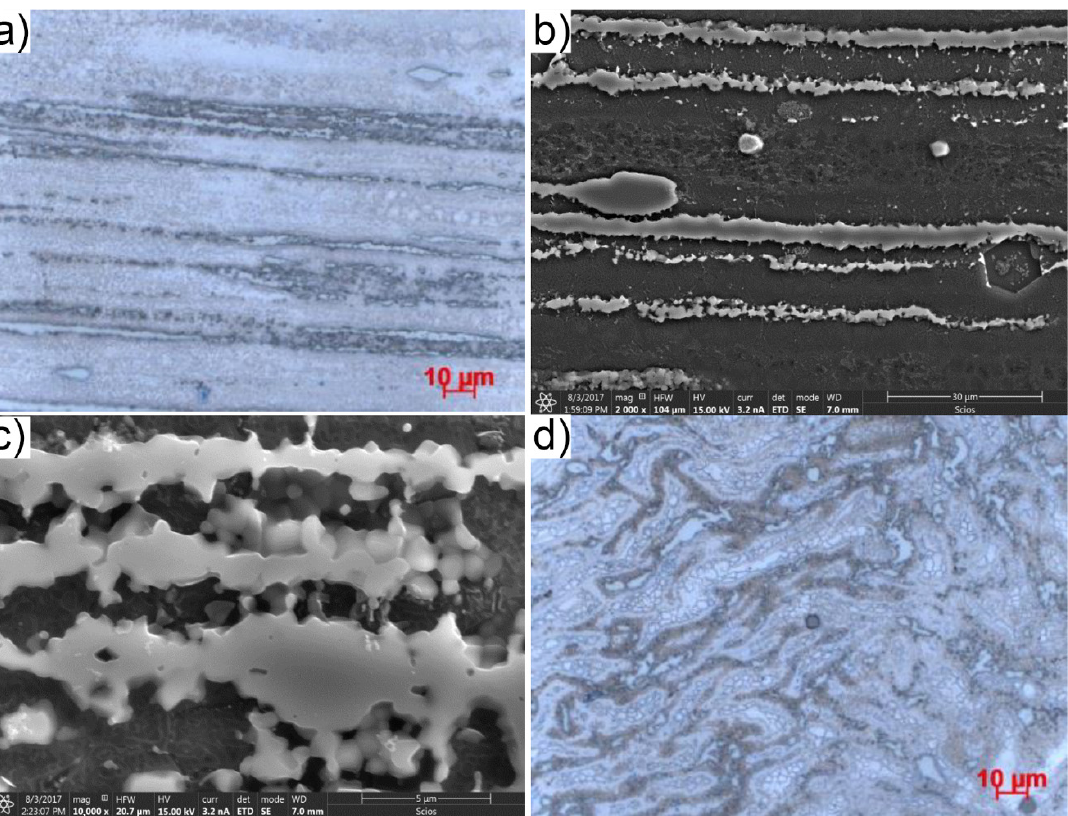
Figure 4. Microstructure of AZ91 (MgAl9Zn1) sand casting magnesium alloy after KOBO extrusion with the processing degree λ = 44.4 and the die rotation frequency f = 6 Hz ( a–c ) longitudinal section, ( d ) cross section.